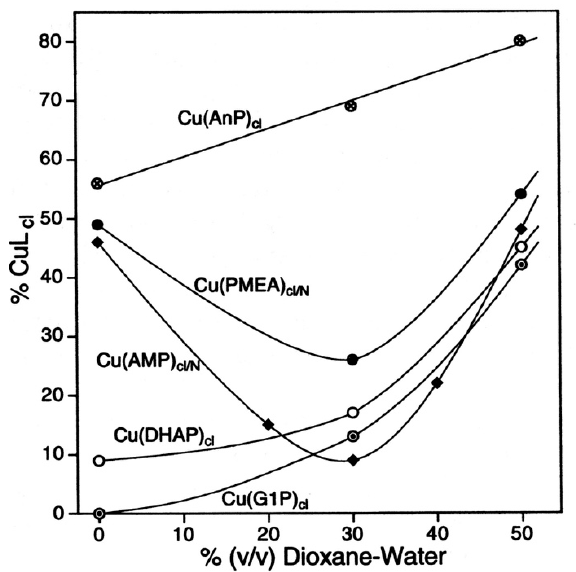
Figure 19. Formation degrees of the chelated isomers, CuL cl , in the Cu(AMP) and Cu(PMEA) systems (Table 11) as well as for comparison in the Cu(DHAP) [47], Cu(G1P) [47], and Cu(AnP) [41,47,154] complex systems (Figure 20) as a function of the percentage of 1,4-dioxane added to an aqueous reagent mixture. All the plotted equilibrium constants refer to 25 °C and I = 0.1 M (NaNO 3 ). This figure is reproduced with permission from our publication in Coordination Chemistry Reviews [47]; copyright 2000, Elsevier, Science S.A., Lausanne, Switzerland).